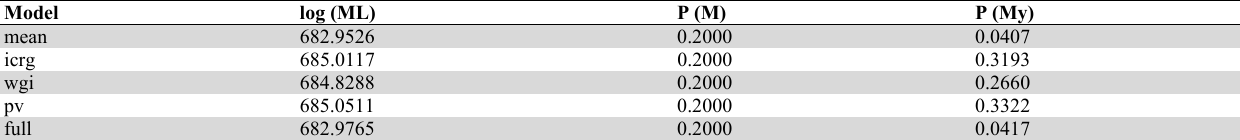
Posterior probabilities of the five models